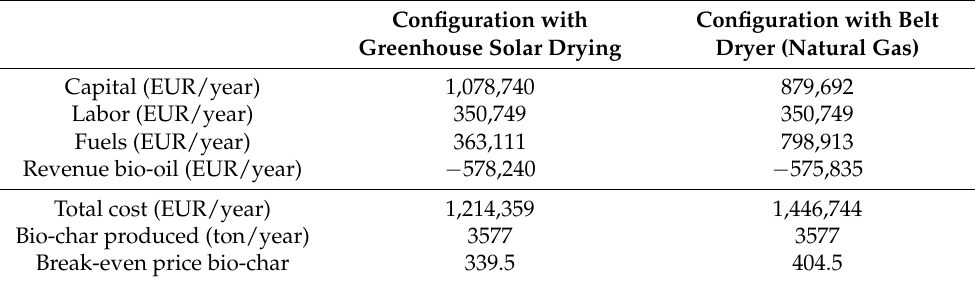
Table 3. Break-even price in EUR of bio-char (base case with 3577 tons bio-char per year). Configuration with